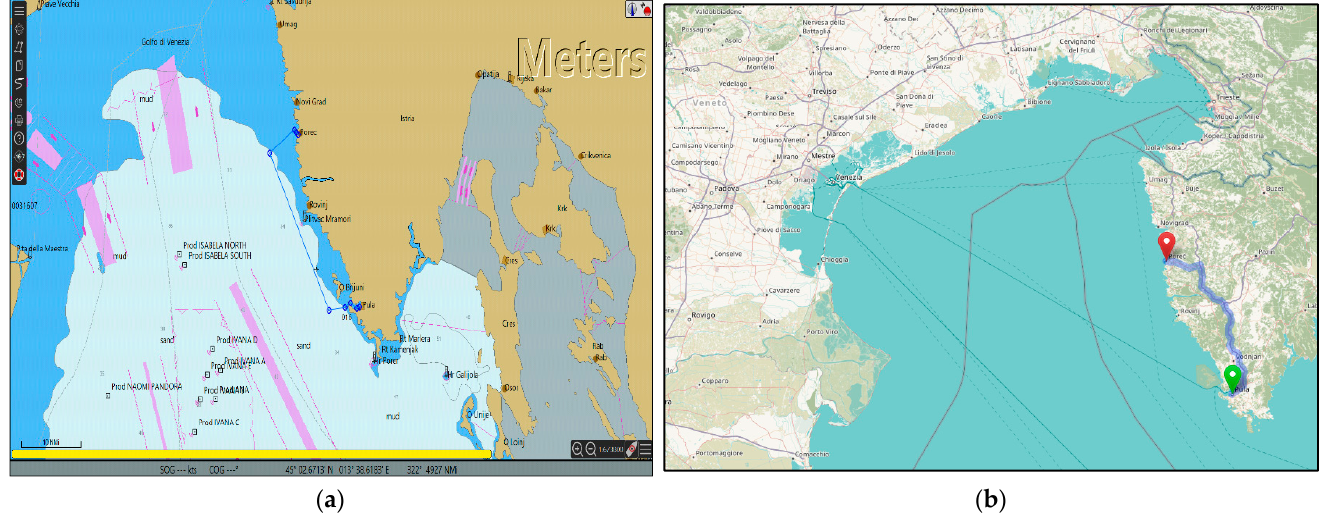
Figure 4. Route segment 𝑅 (cid:2869) 𝑆 (cid:2870) : ( a ) maritime transportation; ( b ) road transportation. Table 7. Distances traveled in the specific navigation mode on the route segment 𝑅 (cid:2869) 𝑆 (cid:2870) . Route Segment: 𝑹 𝟏 𝑺 𝟐 Maneuvering on departure